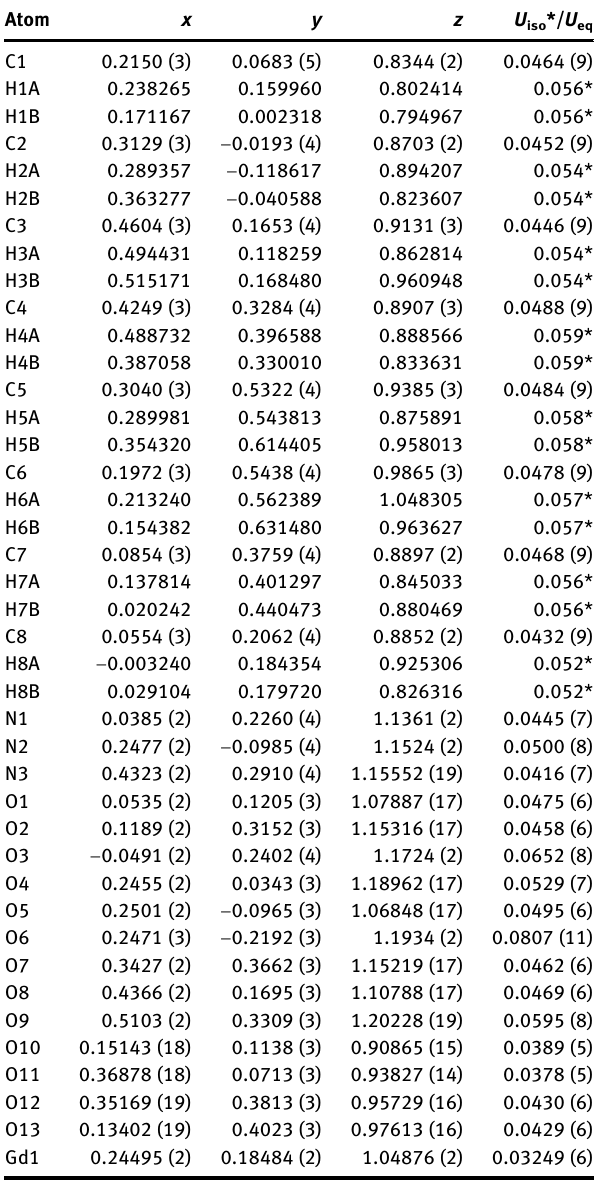
Table  : Fractional atomic coordinates and isotropic or equivalent isotropic displacement parameters (Å 